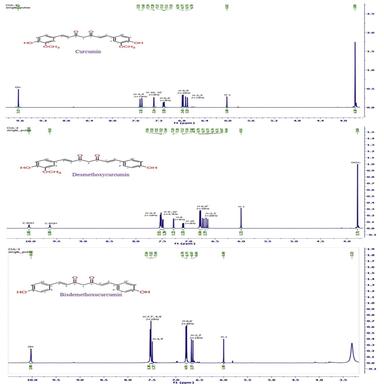
1 HNMR spectrum of curcumin, desmethoxycurcumin, and bisdemethoxycurcumin.